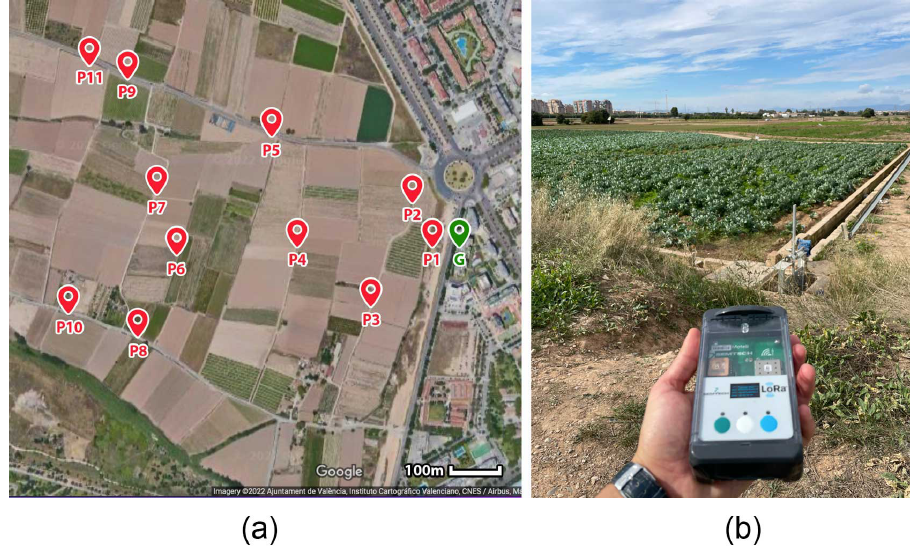
Figure 4. Experimental setup for outdoor LoRa communication test. ( a ) P1 to P14 represent the measurement locations, G represent the gateway location. ( b ) LoRa Mote II used as LoRa